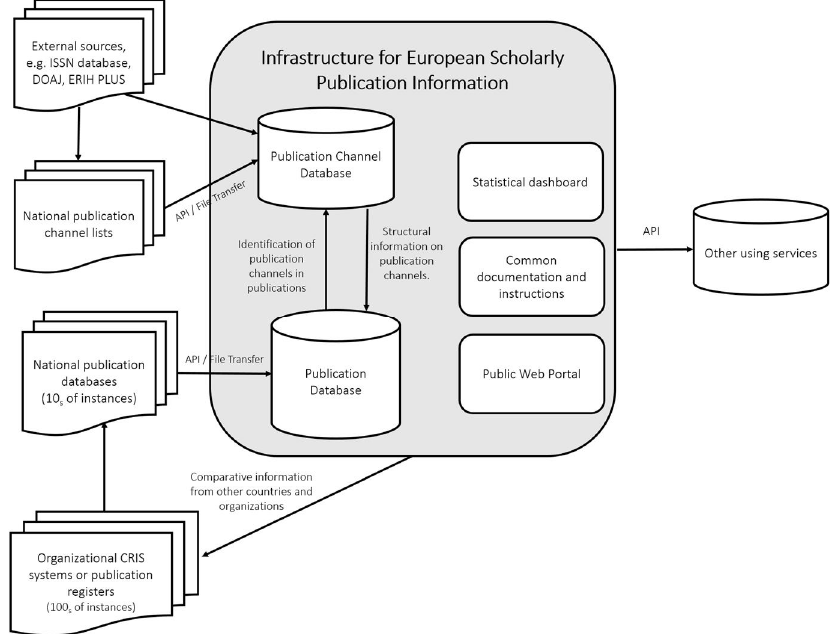
Fig. 2 . Outline of the solution for European Publication Information